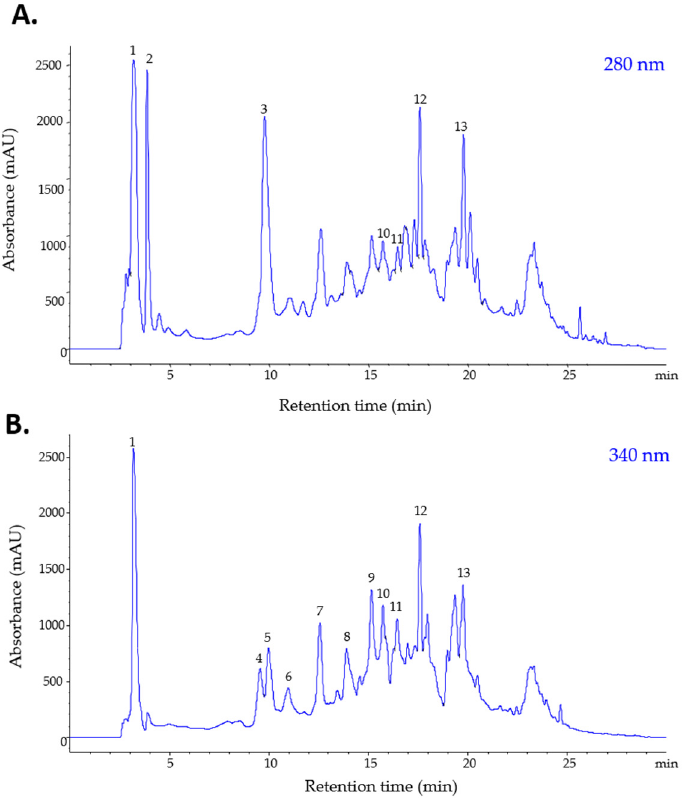
Figure 1. HPLC-PDA chromatograms of phenolics and alkaloids from the S. bulbocastanum extract, recorded at 280 ( A ) and 340 nm ( B